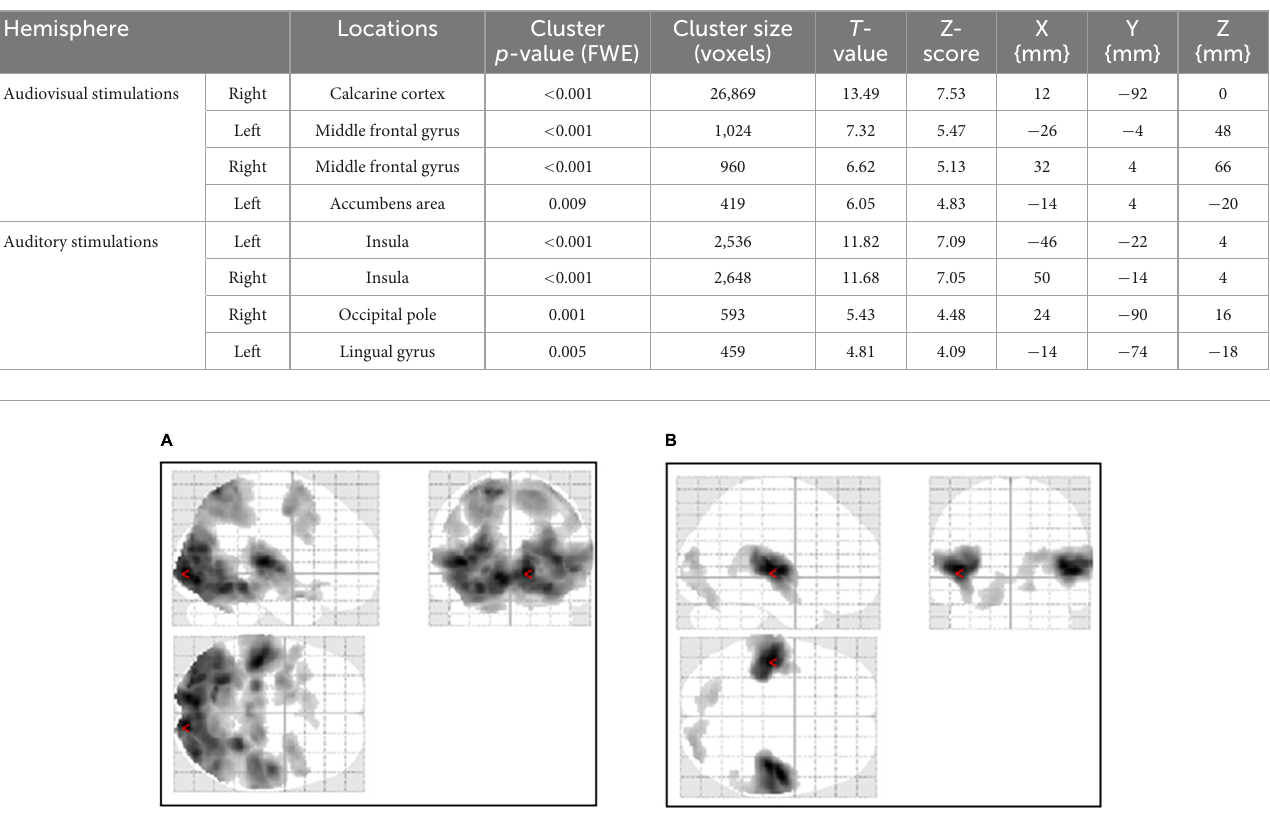
TABLE 2 Significantly activated areas and T -values of stimulation task performance. Hemisphere Locations